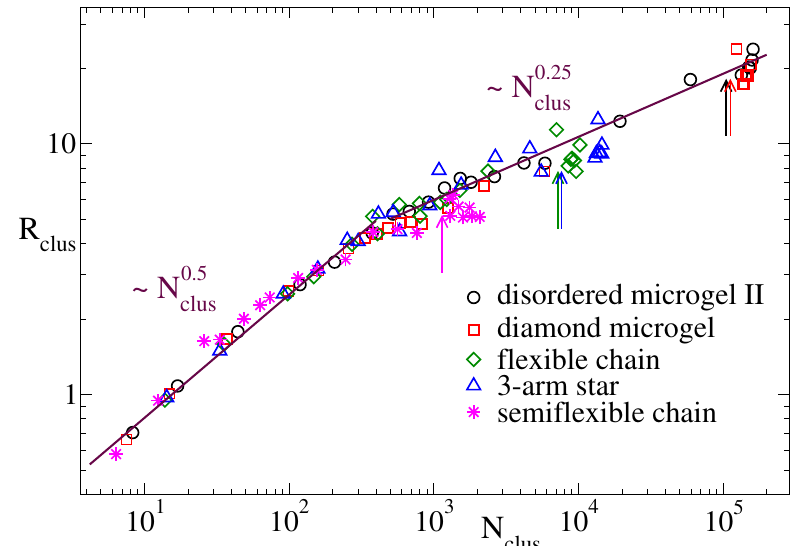
Figure 5. Mean cluster radius vs. mean cluster population at φ = 1.2, for clusters of filled cells in the density field representation with parameters r c = 1.0 and ρ min = 0.6. Data are shown for the disordered microgel of middle asphericity, the diamond network, the three-arm star and the flexible and semiflexible linear chains. The arrows indicate the approximate cluster population at the saturation point prior the formation of the late plateau in N clus ( t ) . Lines are power-laws, exponents are